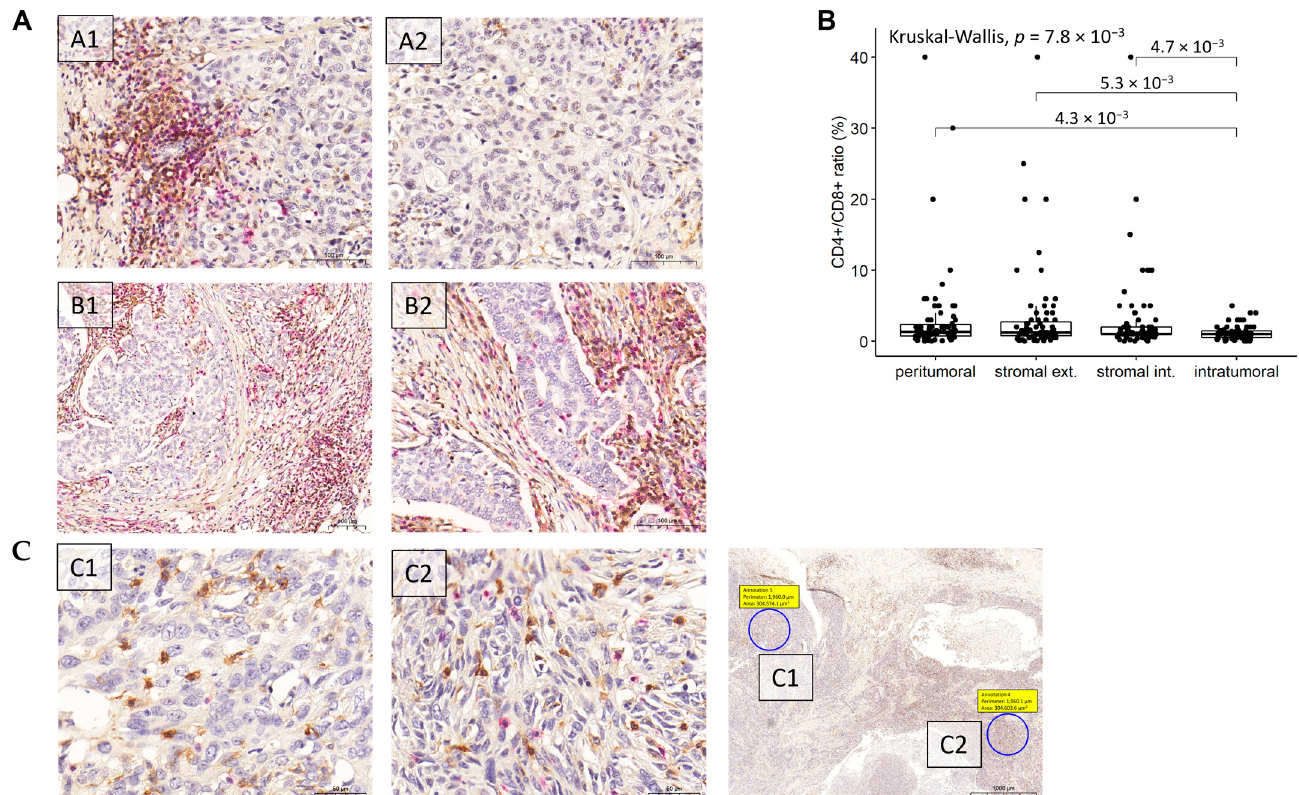
Figure 3. Spatial distribution of CD4+, CD8+ cells: ( A ), Representative IHC images of CD4 + (brown) and CD8 + (red) immune cells. A1–A2: CD4 + and CD8 + immunostaining of a HER2+ breast carcinoma subtype of grade 2, pT1c, pN0. High peritumoral CD4 + and CD8 + expression (A1). Markedly reduced CD4 + and CD8 + expression in the intratumoral region of the tumor (A2). ( B ), B1–B2: CD4 + and CD8 + immunostaining of grade 2, pT2, pN1 LUMB1 breast carcinoma case. High peritumoral and stromal